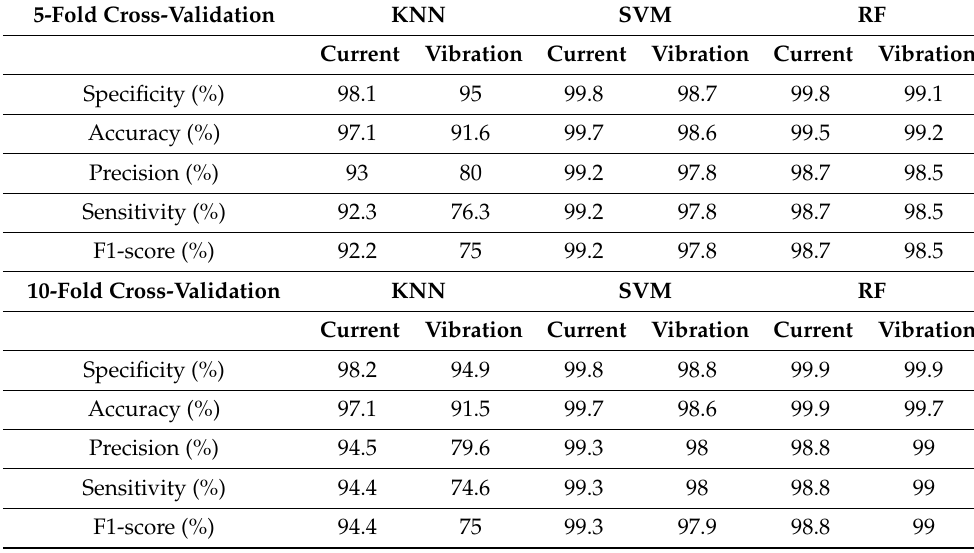
Table 7. Classification results applying Invasive Weed